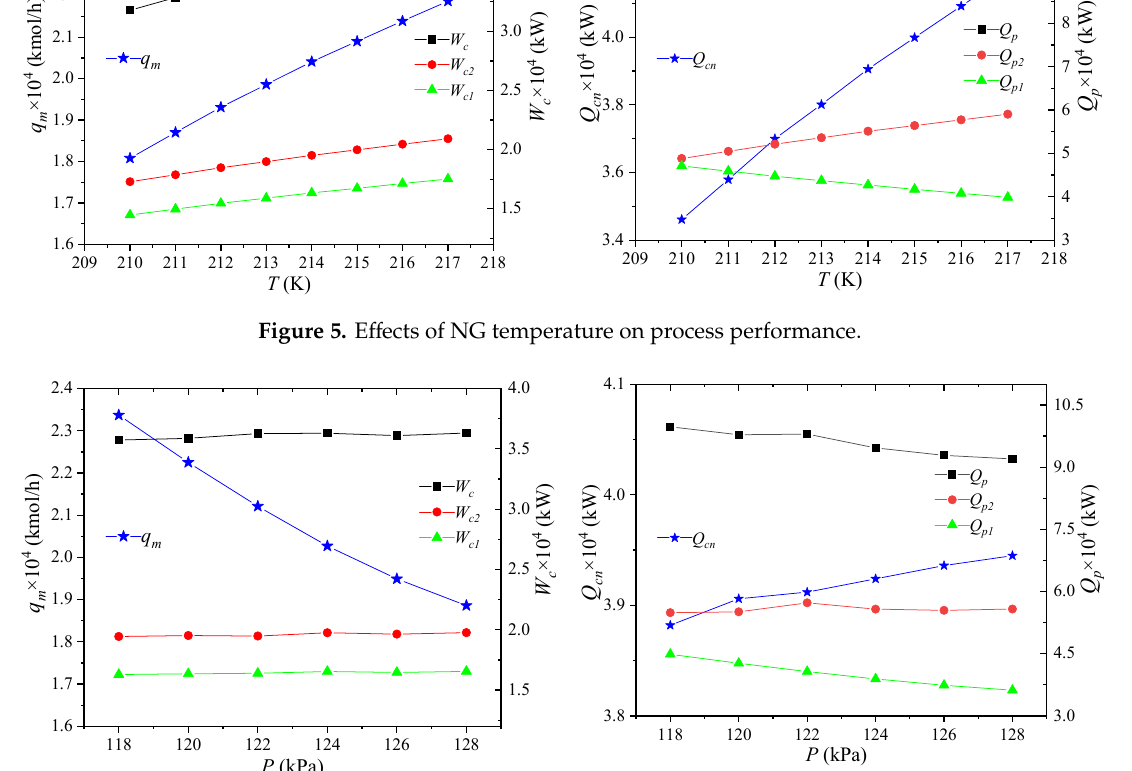
Figure 6. E ff ects of NG storage pressure on process